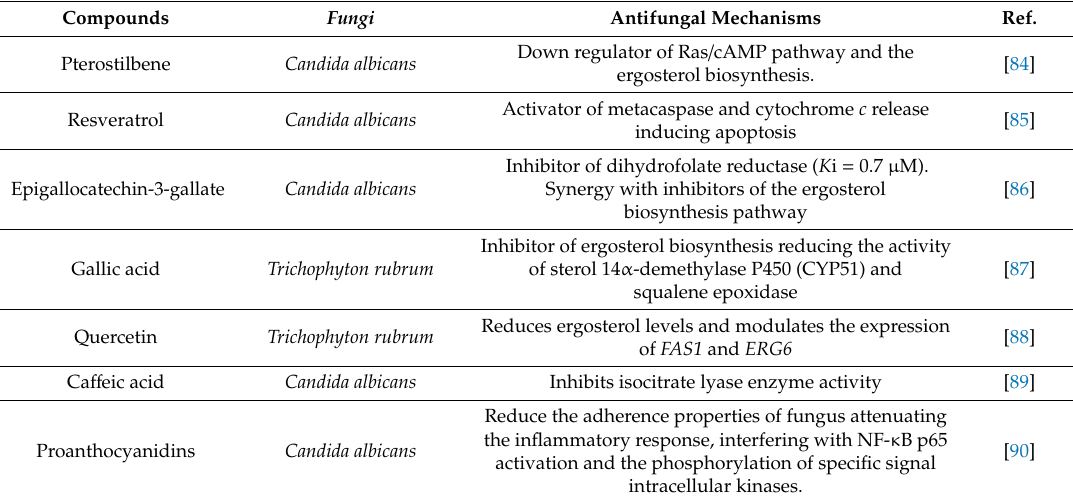
Table 4. Antifungal mechanisms of single phenolic compounds against human fungal pathogens. Compounds